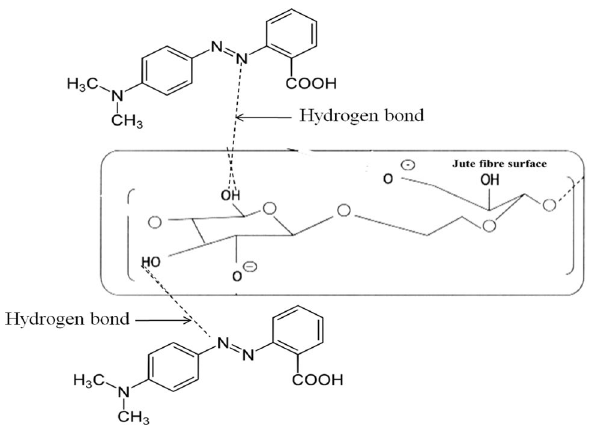
Fig. 25 Mechanism for MR sorption onto